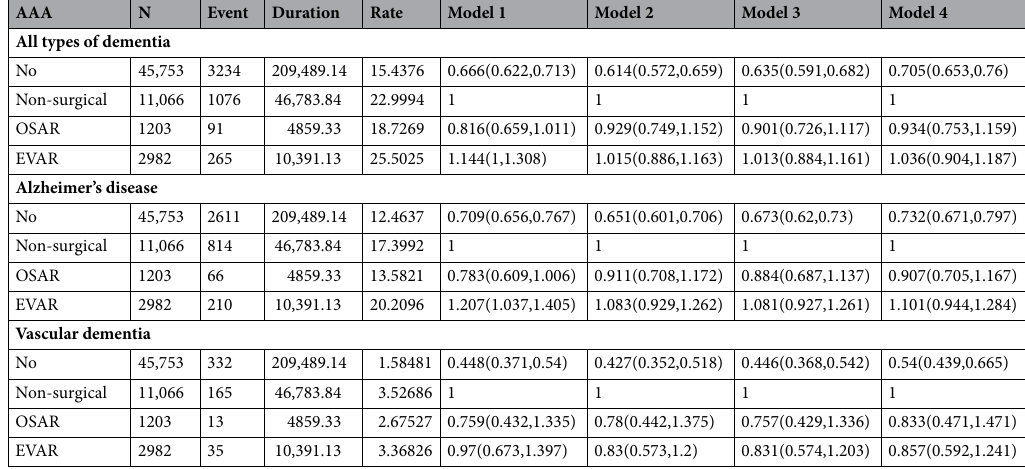
Table 4. Hazard ratio of AAA for incidence of dementia. OSAR Open surgical aneurysm repair, EVAR Endovascular aneurysm repair, Surgical group divided into OSAR and surgical